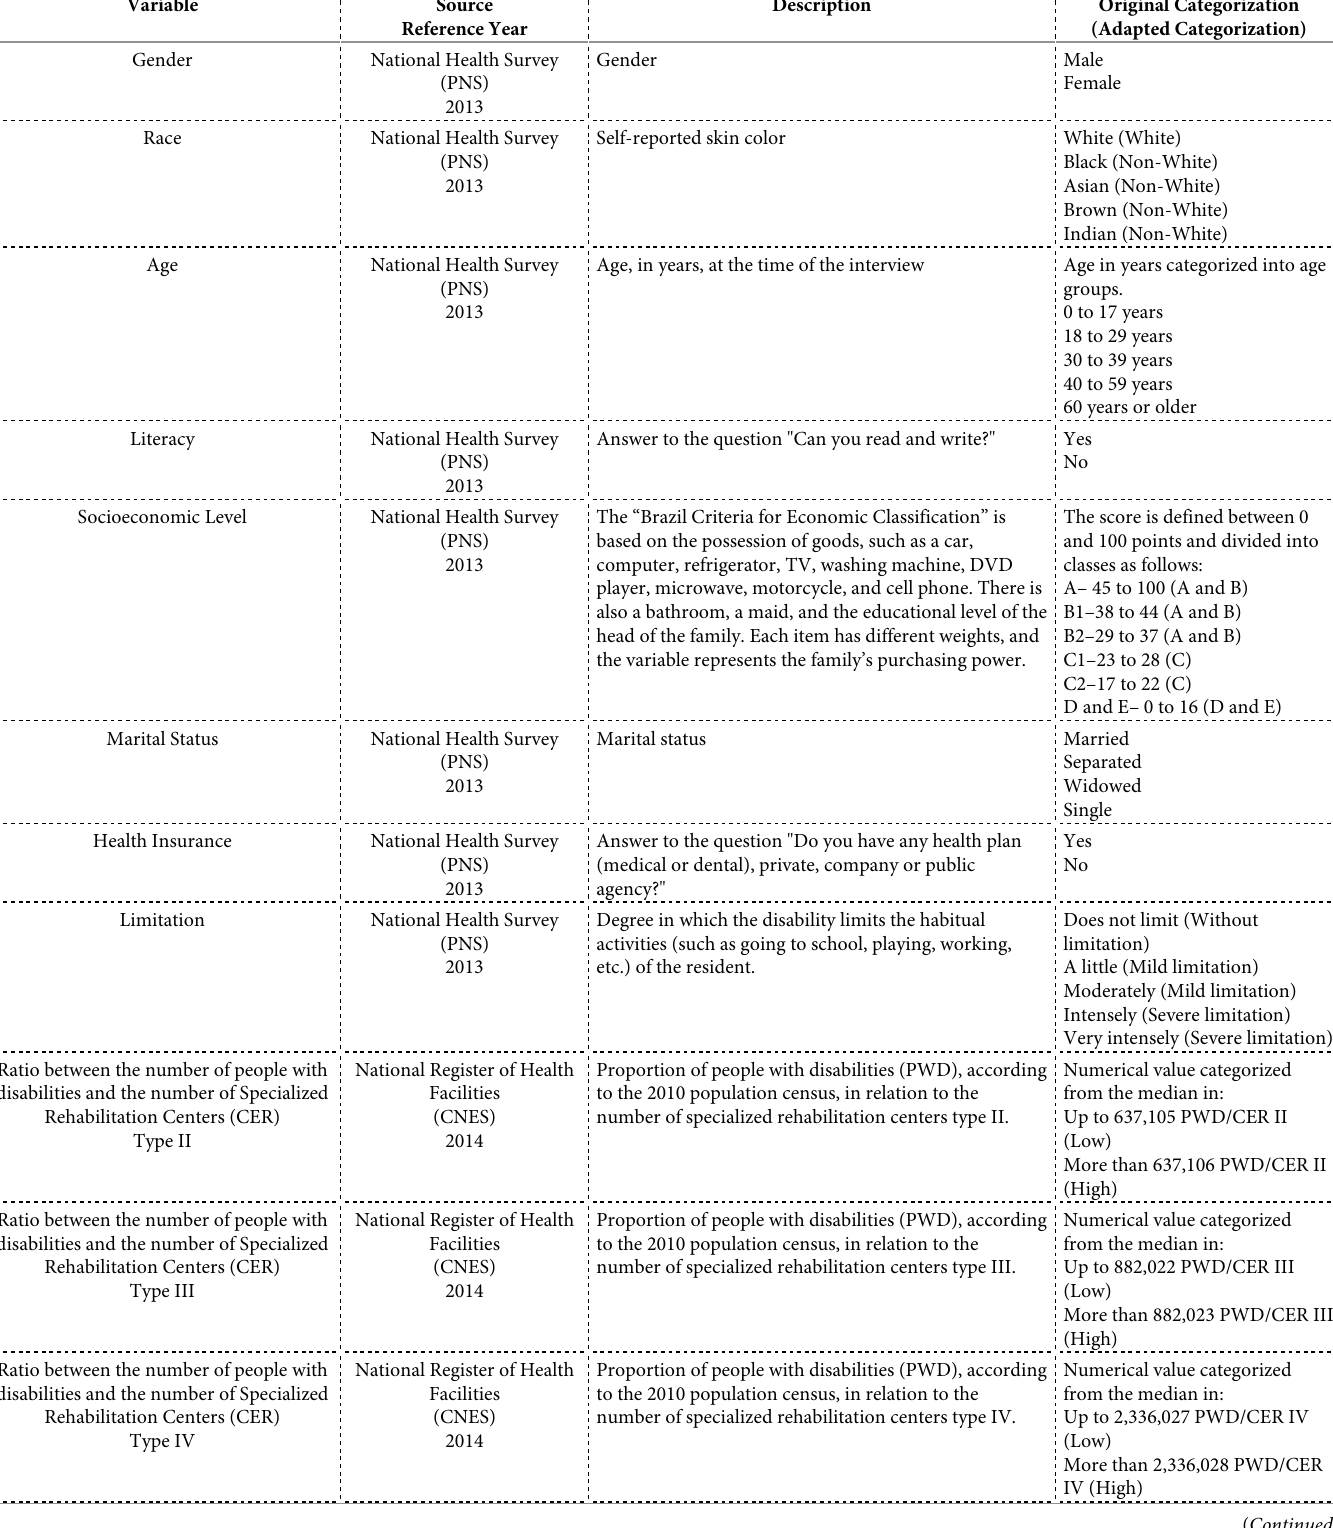
Table 1. Description of the individual and contextual variables of the study and adaptation strategies for the analysis model. Brazil,